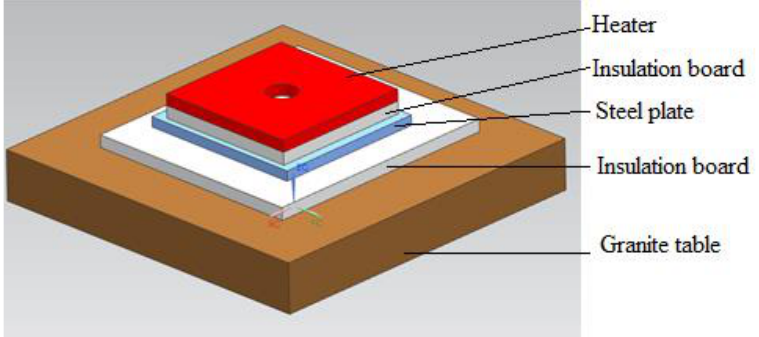
Figure 5. Validation model simulation.